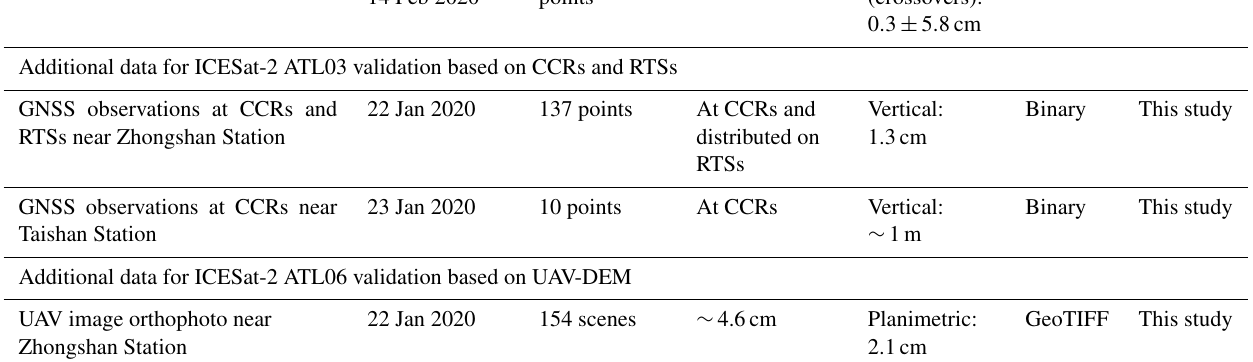
ICESat-2 ATL06 Release 003 GNSS observations along traverse